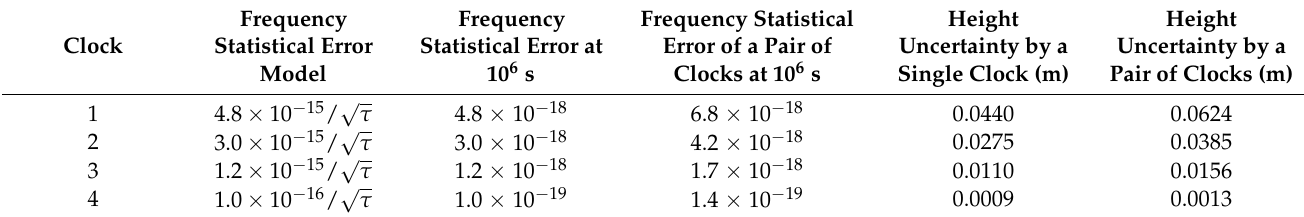
Figure 5. Frequency statistical error of different optical clocks. Table 2. Frequency statistical error parameters of existing and future optical clocks.